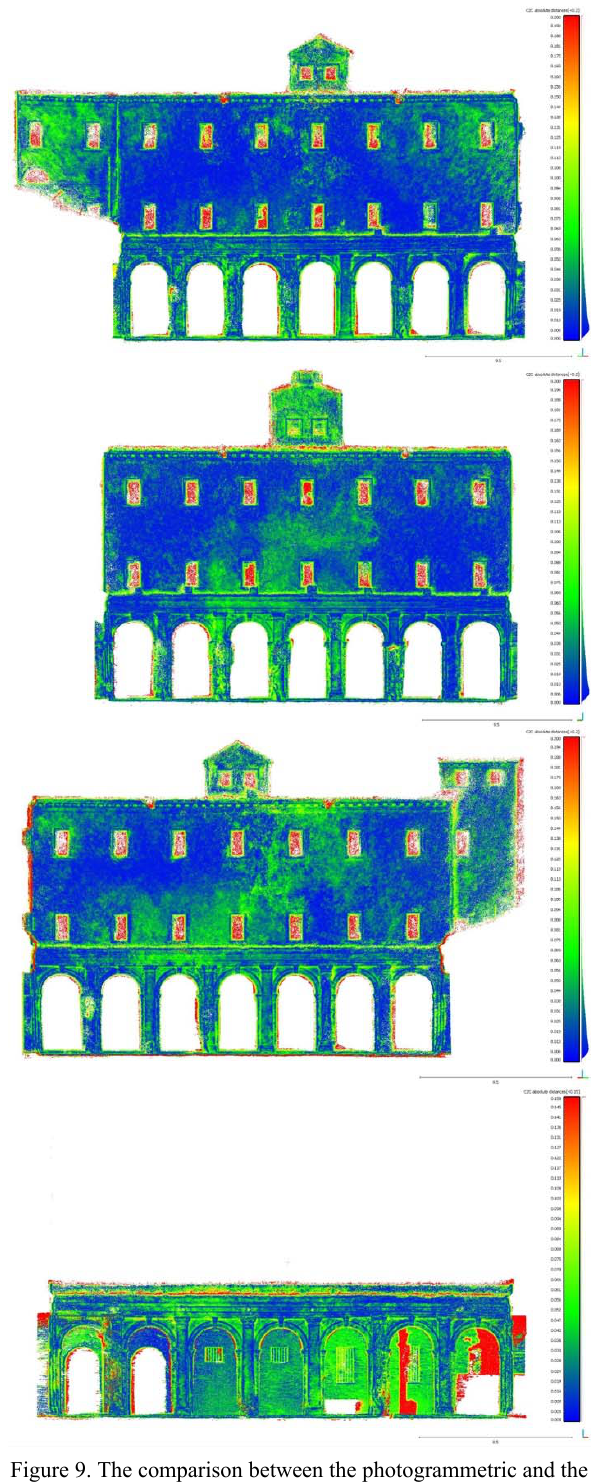
Figure 9. The comparison between the photogrammetric and the laser scanning point cloud of the four façades of the cloister. The previous images (Fig. 9) show the analyses carried out with the four photogrammetric façades compared with the respective laser scanning fronts. The comparison range has been set from 0 to 20cm: the metric result is based on calculation of the minimum distance between each point of the two models using the Nearest Neighbor algorithm.